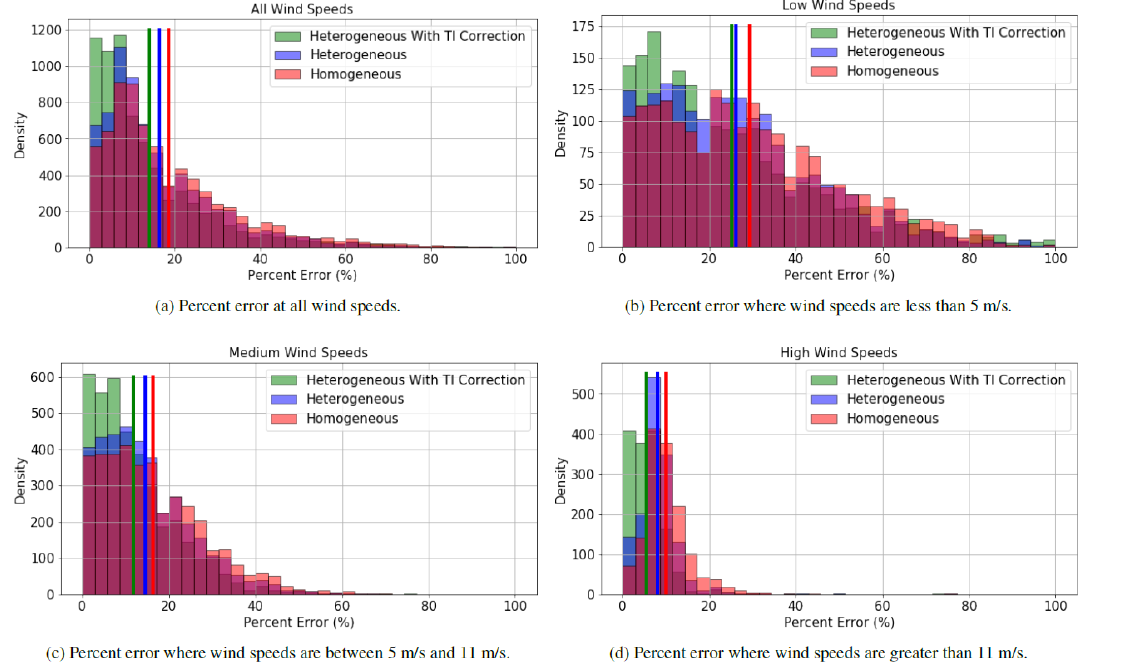
Figure 19. Percent error of all three FLORIS models, plotted for comparison within varying ranges of wind speeds. Table 1. Mean absolute percent error in total wind farm power output for all FLORIS models, tabulated for comparison within varying ranges of wind